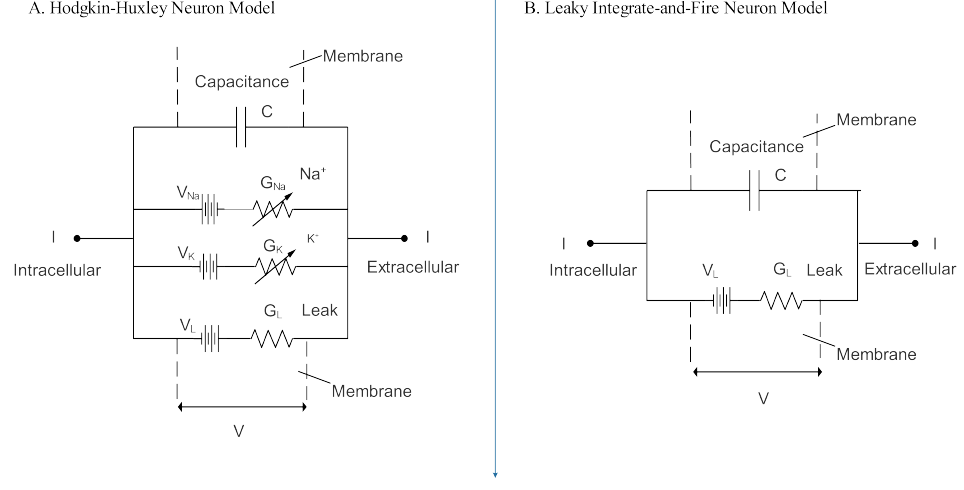
Figure 1. The electrical equivalent circuit of ( A ) Hodgkin-Huxley neuron model and ( B ) Leaky Integrate-and-Fire neuron